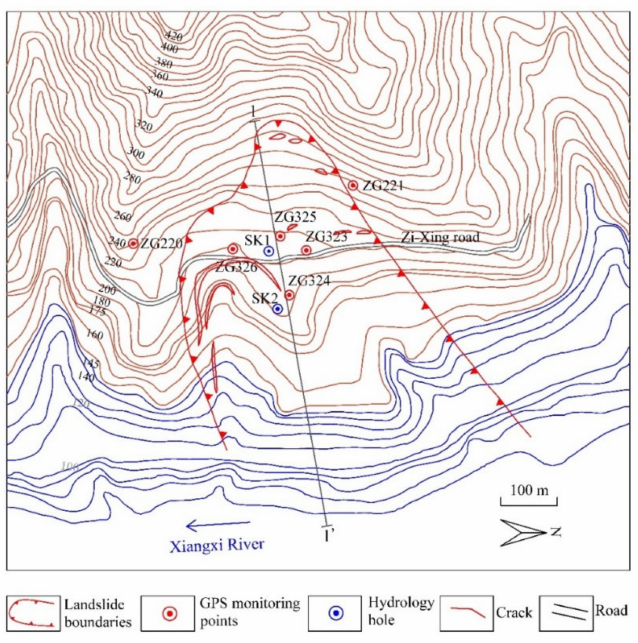
Figure 6. Monitoring arrangement in the Baijiabao